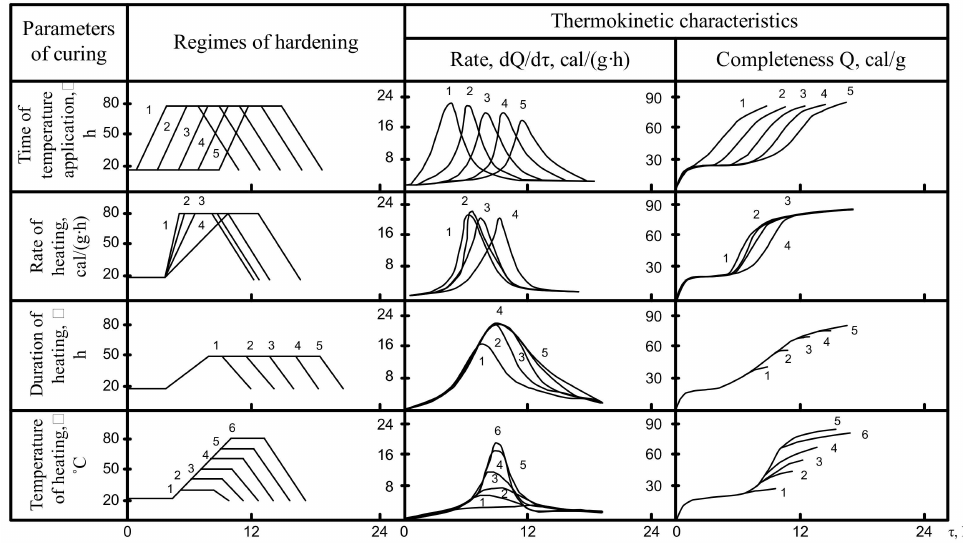
Figure 5. The influence of heat curing parameters on thermokinetic characteristics of the cement hydration in the clinker + water system.